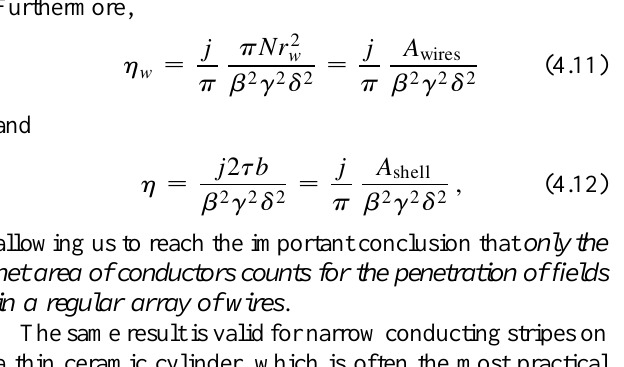
FIG. 4. Cavity of finite